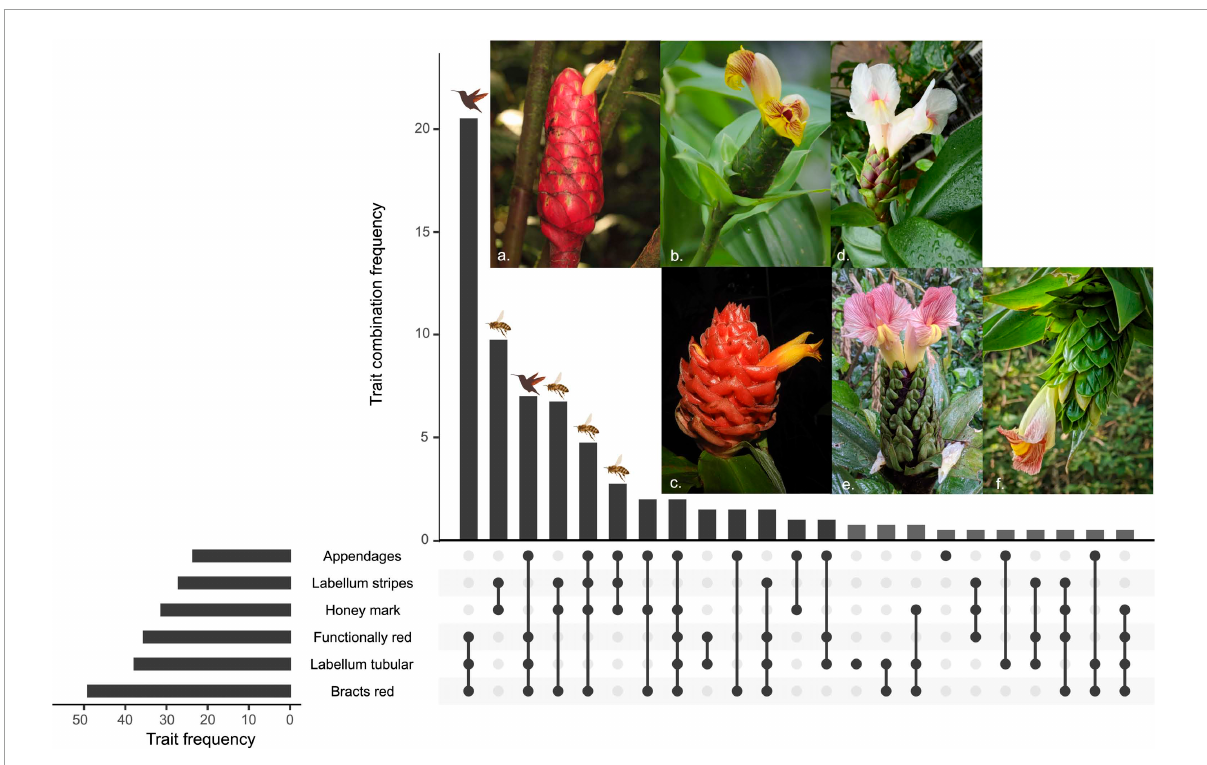
FIGURE2 Frequency of the analyzed traits and their combinations in our sampling. Traits were variable for some taxa and the weight was divided into the possible combinations within each lineage (maximum four combinations due to two variable traits). Gray bars represent combinations only observed in lineages with polymorphic traits (combinations only observed because of the permutation of two polymorphic traits were excluded). Ornithophilous and mellitophilous syndromes are indicated with the bee or hummingbird icons when trait combinations match all the expectations of the pollination syndromes. Examples of species showing the first six trait combinations are shown in the photographs corresponding to the following species: (a) Costus plowmanii Maas, (b) Costus dirzoi García-Mend. & G.Ibarra, (c) Costus ricus Maas &